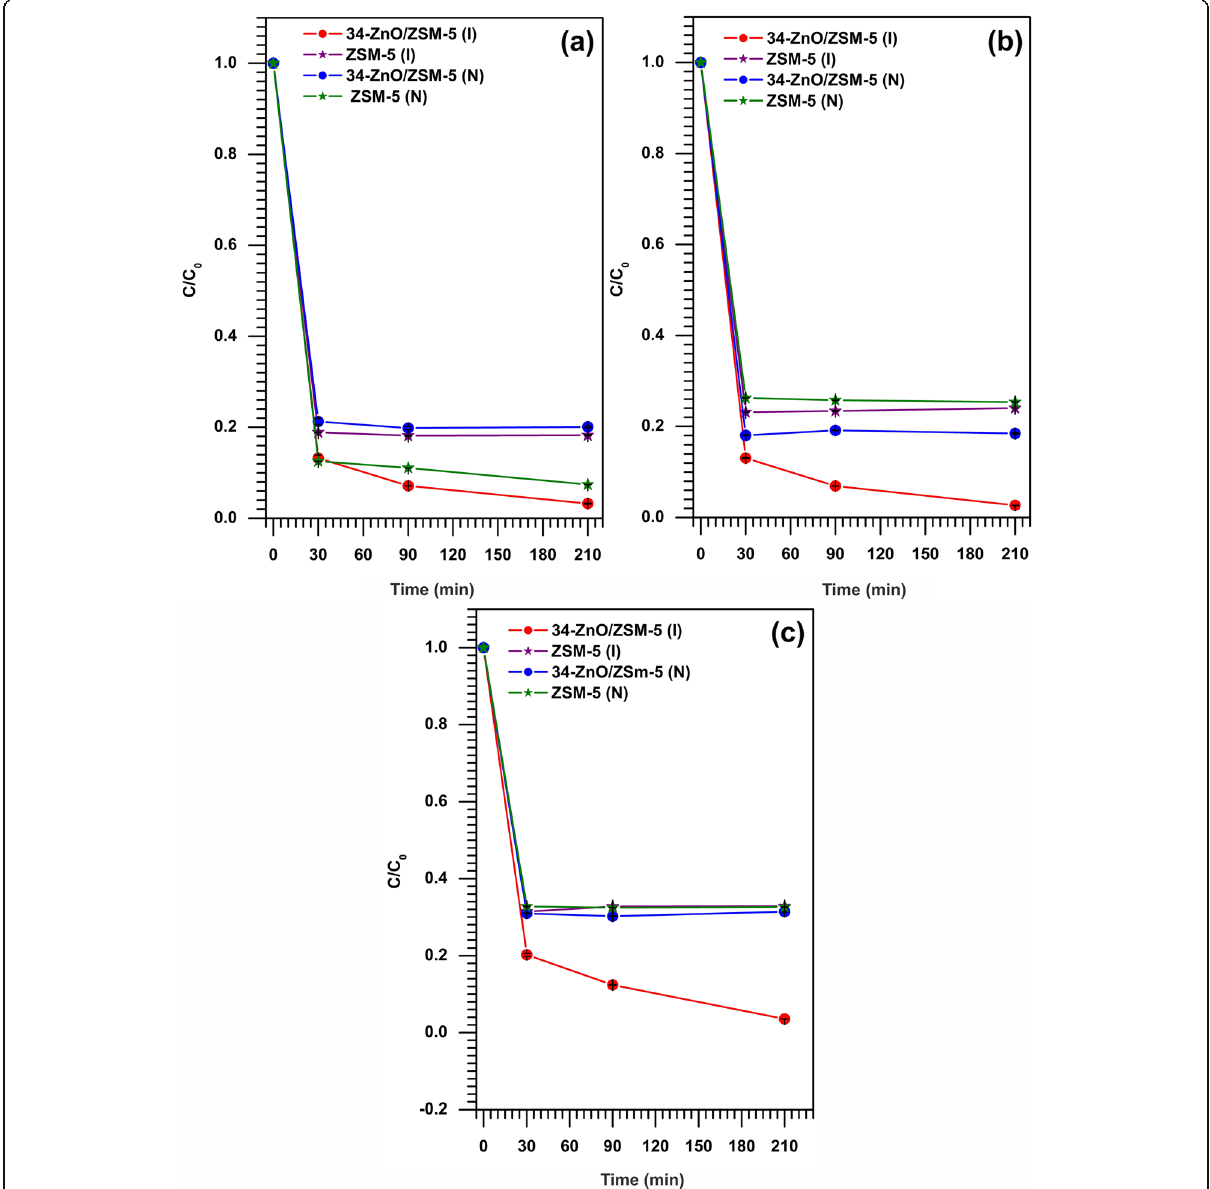
Fig. 9 Influence of the initial MB concentration at ( a ) 80 mg L − 1 , ( b ) 90 mg L − 1 and ( c ) 100 mg L − 1 with UV-LED irradiation (I) and without irradiation